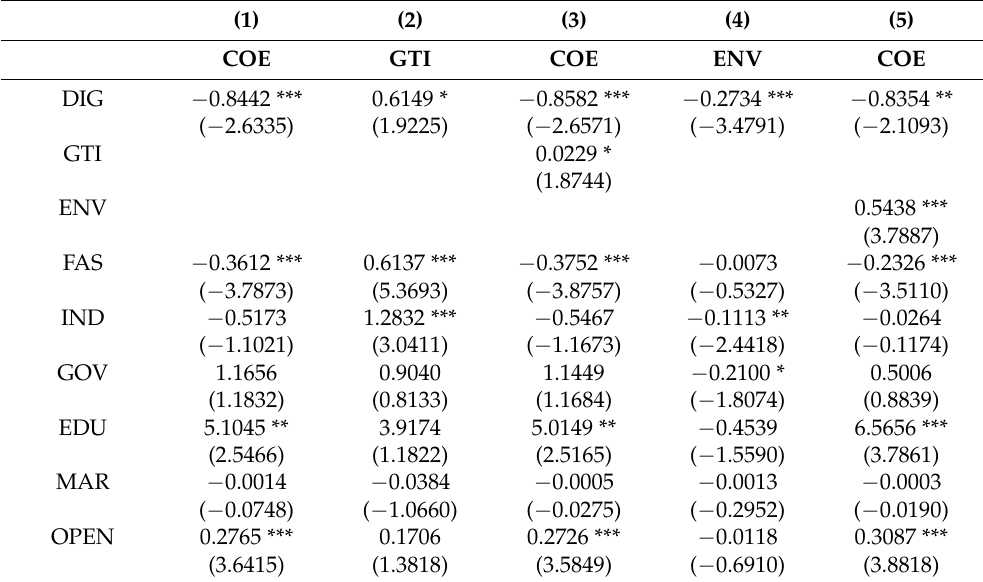
Table 9. The intermediary effect test of green technology innovation and environmental